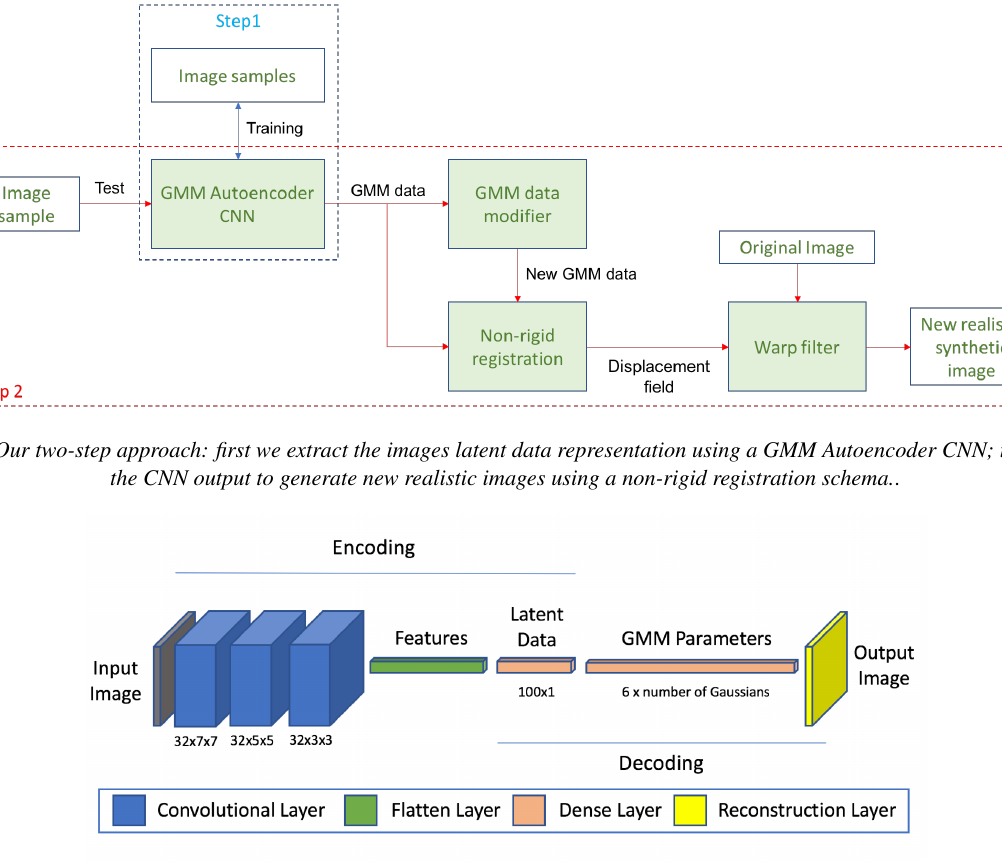
Figure 3. The GMM enconder-decoder architecture is presented in details. Our proposed architecture has a encoder composed by three convolutional layers, followed by a Flatten layer that creates a feature array, and a dense layer that creates the latent data information; and a decoder that gets the latent data information and maps it into GMM parameters through another dense layer, ultimately used to reconstruct the density output image. A trained network is capable of mapping from connvolutional features to latent data, and from latent data to a GMM that resembles the input